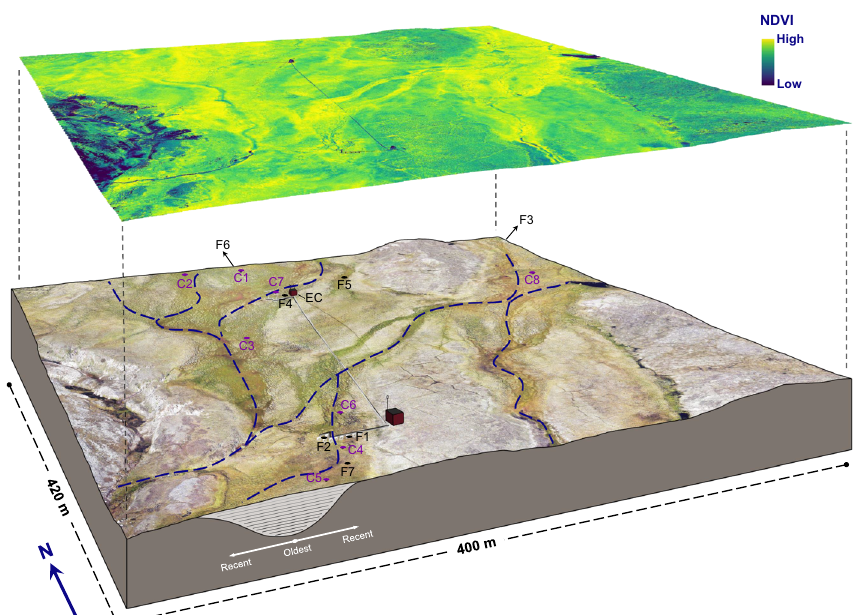
Figure 1. Angled view of the DEM-based orthophoto illustrating the Zackenberg fen site across a 400 m × 450 m area. The map includes the locations of all cores (Table 1a), CH 4 flux study sites (Table 1b) and EC tower (Table S2) together with an indication of the main surface water flow direction. Additionally, an NDVI map (August 2020) characterising the local plant greenness overlays the map. The areas surrounding the main flow are found to hold the older, deeper peat deposits and hence higher methane emissions. In support of this, the older peat age determinations at C3, C6, C7, and C8 are all located centrally to the hydrological flow lines and coincide with the vicinity of high mcrA gene counts (for C3) and fluxes measured. F3 and F6 are both located approximately 300 m from the edge of the map. Note that the surface topography, infrastructure, and subsurface processes are not to scale. Image source: Greenland Ecosystem Monitoring, 2020.